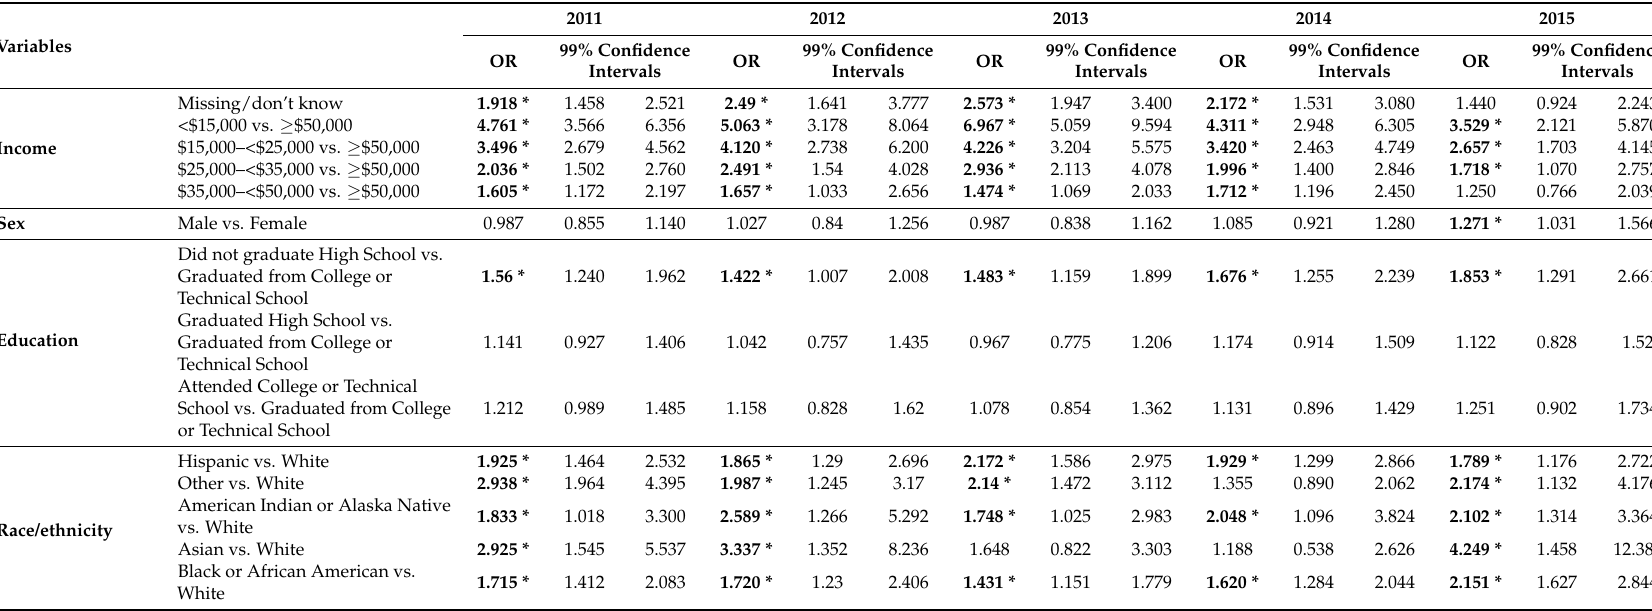
Table 6. Adjusted Analysis for Forgone Care among individuals aged 65 years of age and older including state Medicaid expansion.